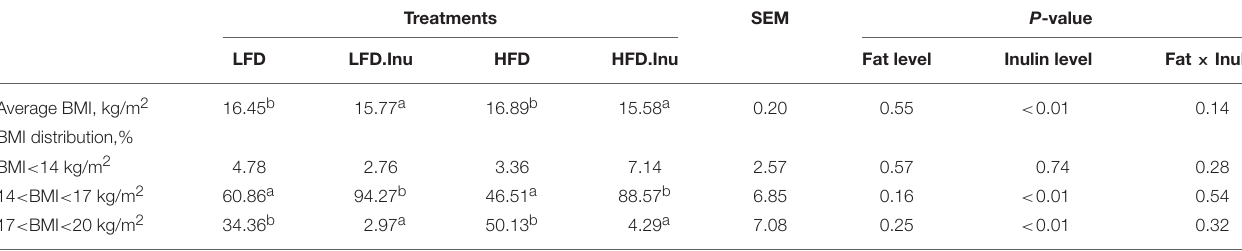
TABLE 1 | Effects of inulin addition to low- or high –fat diets on body mass index (BMI) distribution of neonatal piglets. Treatments SEM P -value LFD.Inu HFD.Inu Fat level Inulin level Fat × Inulin